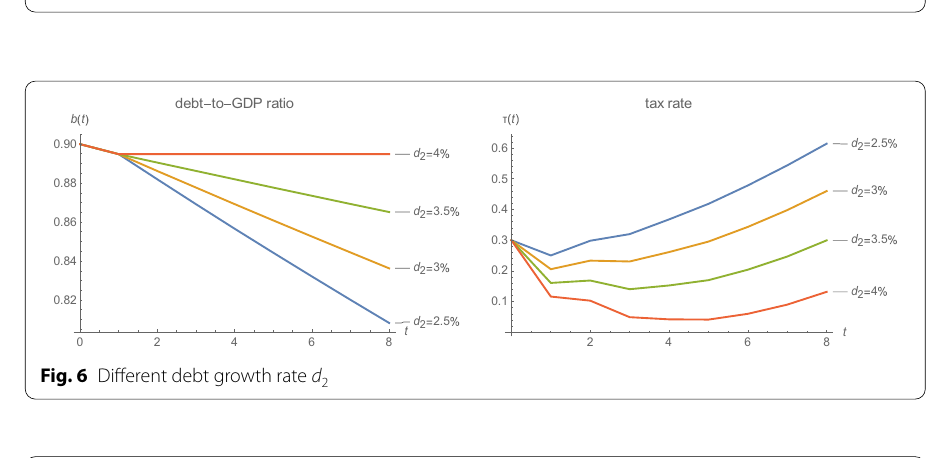
Fig. 5 Different income growth rate d 1